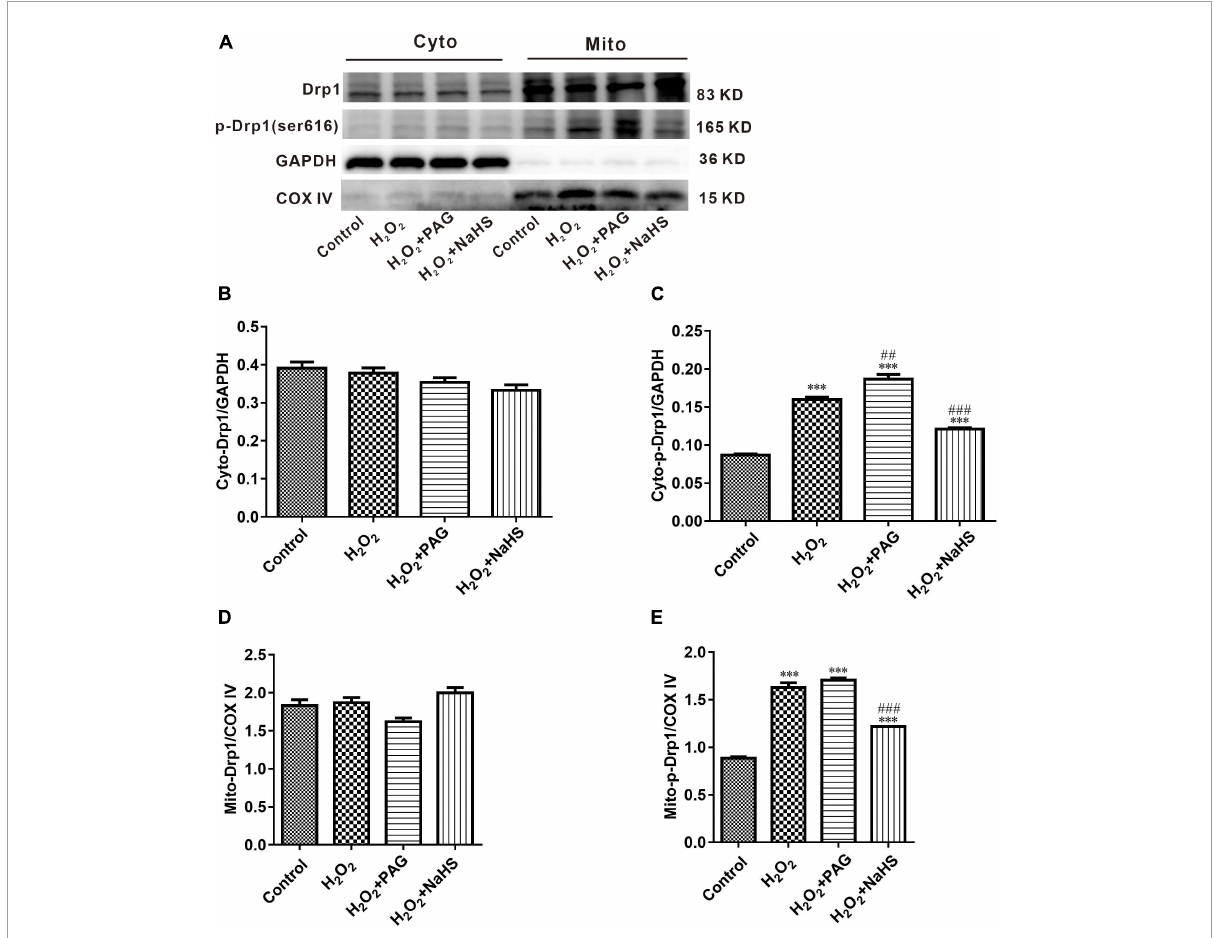
FIGURE5 Effect of NaHS on mitochondrial cleavage and fusion proteins activity in HTR-8/SVneo cells. (A) Representative Western blot showing Drp1, p-Drp1 in cytoplasm and mitochondria in HTR-8/SVneo cells after different treatments. (B–E) Bar charts indicating different proteins between different groups. Results in the cytoplasm were normalized against GAPDH, and results in mitochondria were normalized against COX IV. The data are expressed as mean ± SEM. ∗∗∗ Vs. Control, P < 0.001. ## Vs. H 2 O 2 , P < 0.01. ### Vs. H 2 O 2 , P <